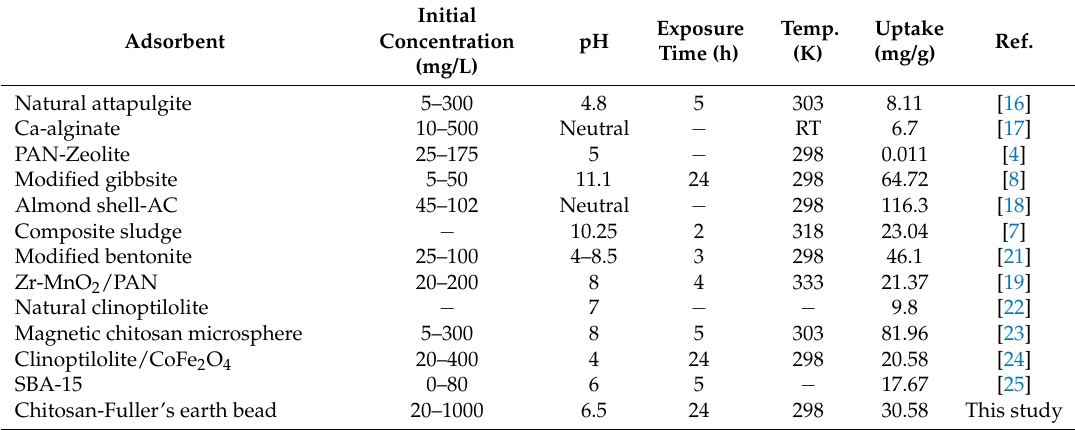
Table 1. Adsorption capacity of various adsorbents for